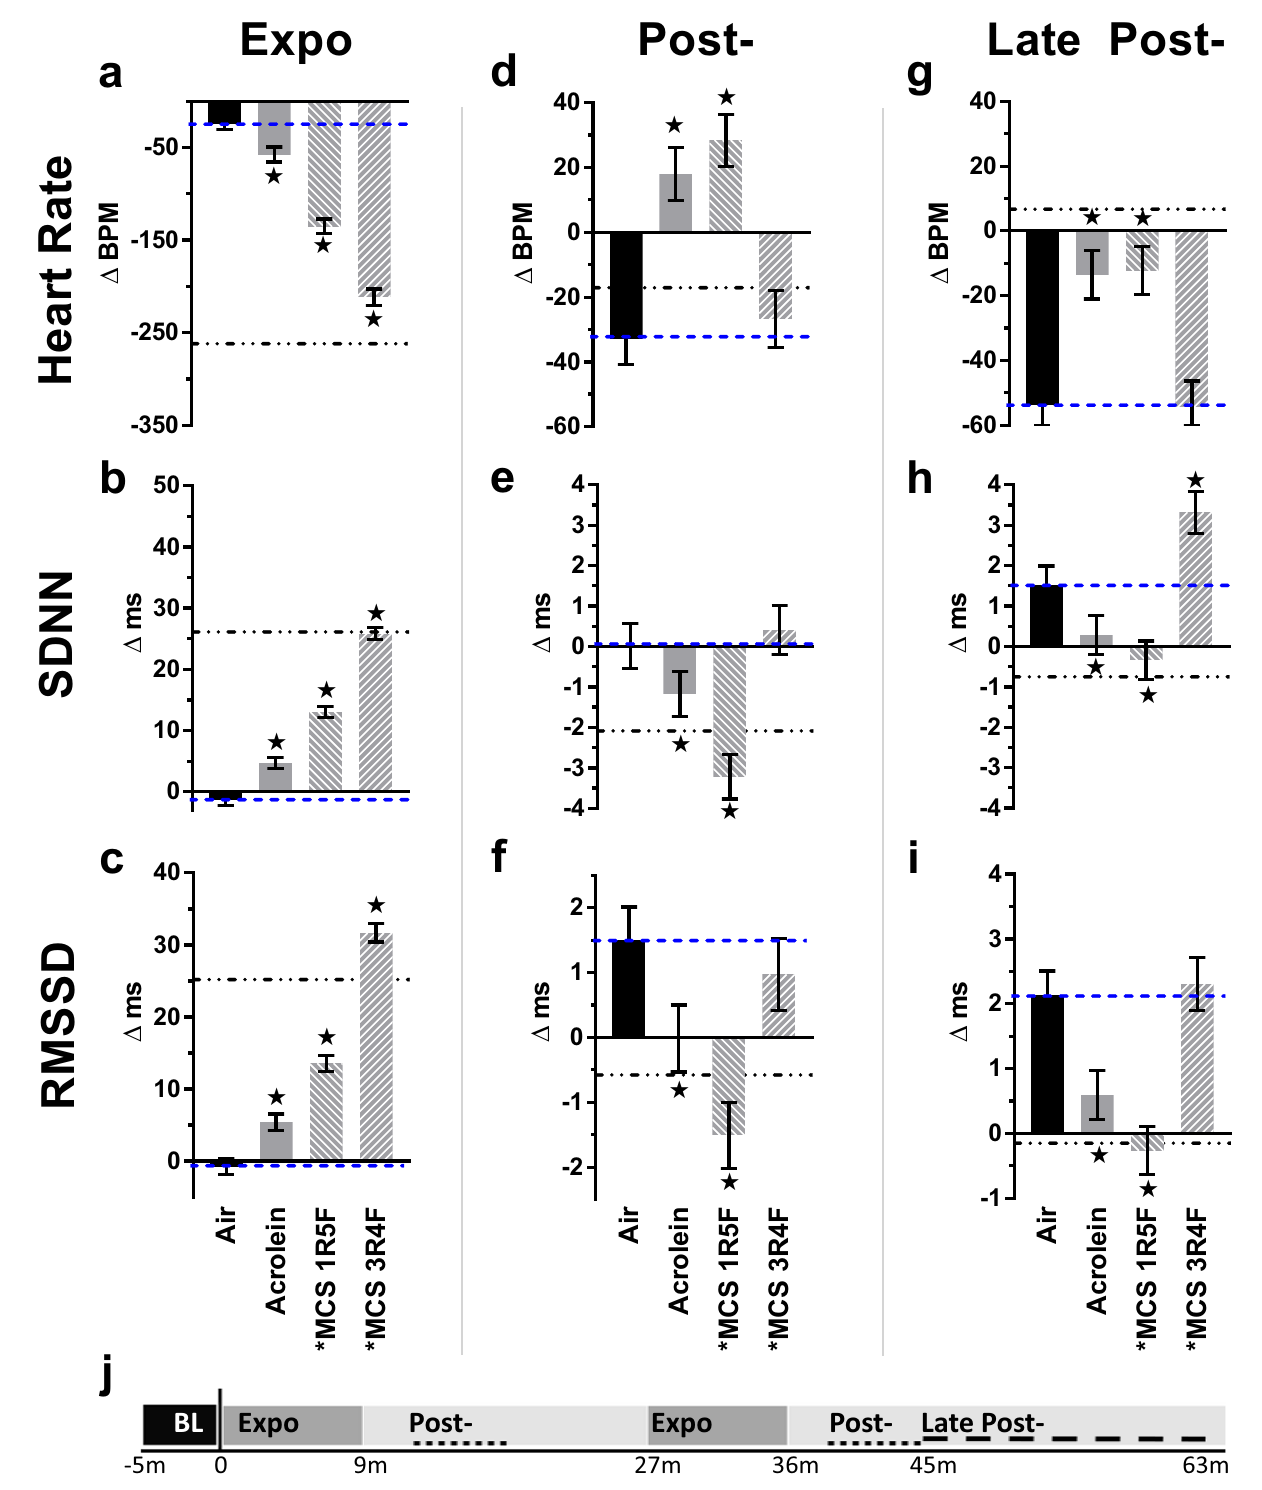
Fig. 7 | Inhalation exposure to MCS or acrolein alters heart rate and heart rate variability (HRV). Bars represent least square means (±SEM) of change from baseline in heart rate and HRV (SDNN and RMSSD) at different exposure phases ( a – i ), indicated by timeline below ( j ), with Expo denoting puff sessions, Post- denoting 4 – 9min after each puff session, and Late Post- indicating 9 – 28min after fi nal puff session. Blue dashes mark Air mean( n =8) and dot-dashes mark VG